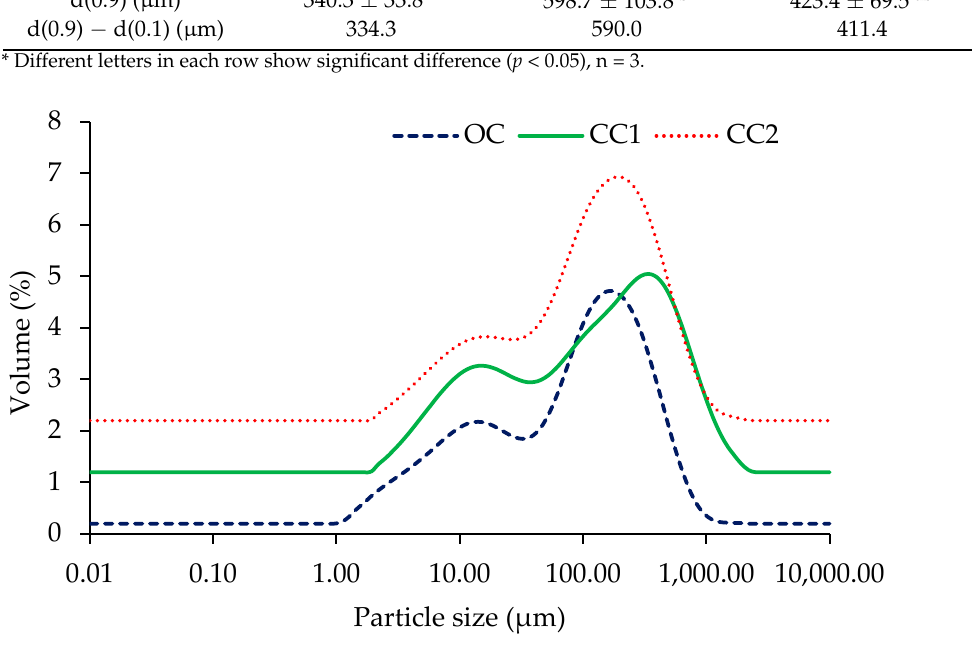
Figure 3. Particle size distribution of 5% ( w / v , on a protein basis) aqueous reconstituted protein extracts from one organically (OC) and two conventionally (CC1 and CC2) cultivated hempseeds. Table 2. Specific surface area (SSA) and particle size distribution of 5% ( w / v , on a protein basis) aqueous reconstituted protein extracts from one organically (OC) and two conventionally (CC1 and CC2) cultivated hempseed samples.